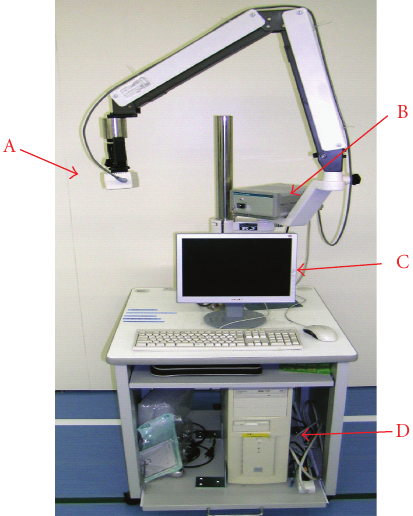
Figure 1: Photograph of the laser flowgraphy system. The laser probe is attached to the tip of the arm. (A) Device for discharging the laser and the mirror. (B) CCD (Charge Coupled Device) image sensor. (C) Monitor screen. (D) Computer used.